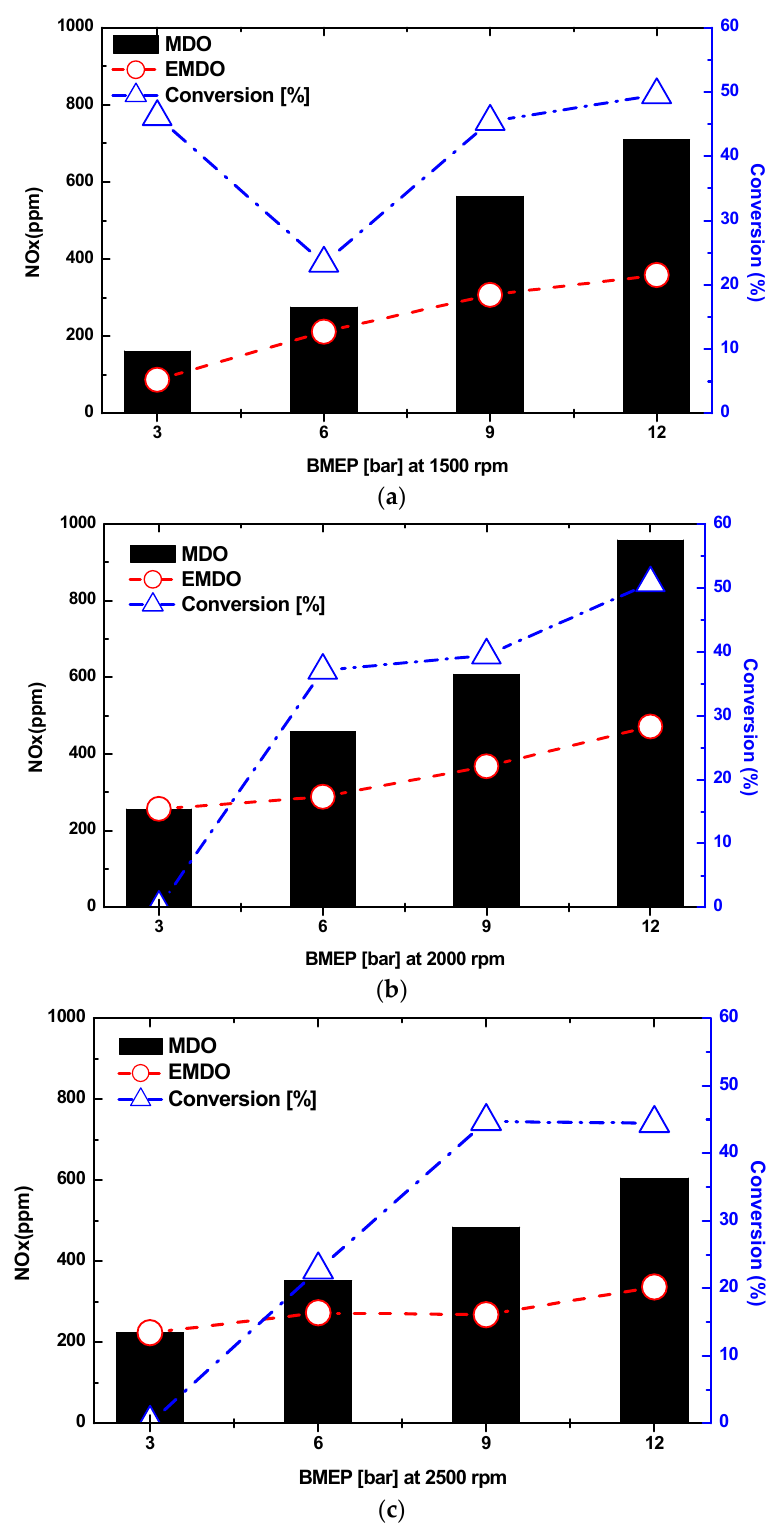
Figure 12. NO x reduction characteristics according to rpm and brake mean effective pressure (BMEP): ( a ) 1500 rpm; ( b ) 2000 rpm; ( c ) 2500 rpm.